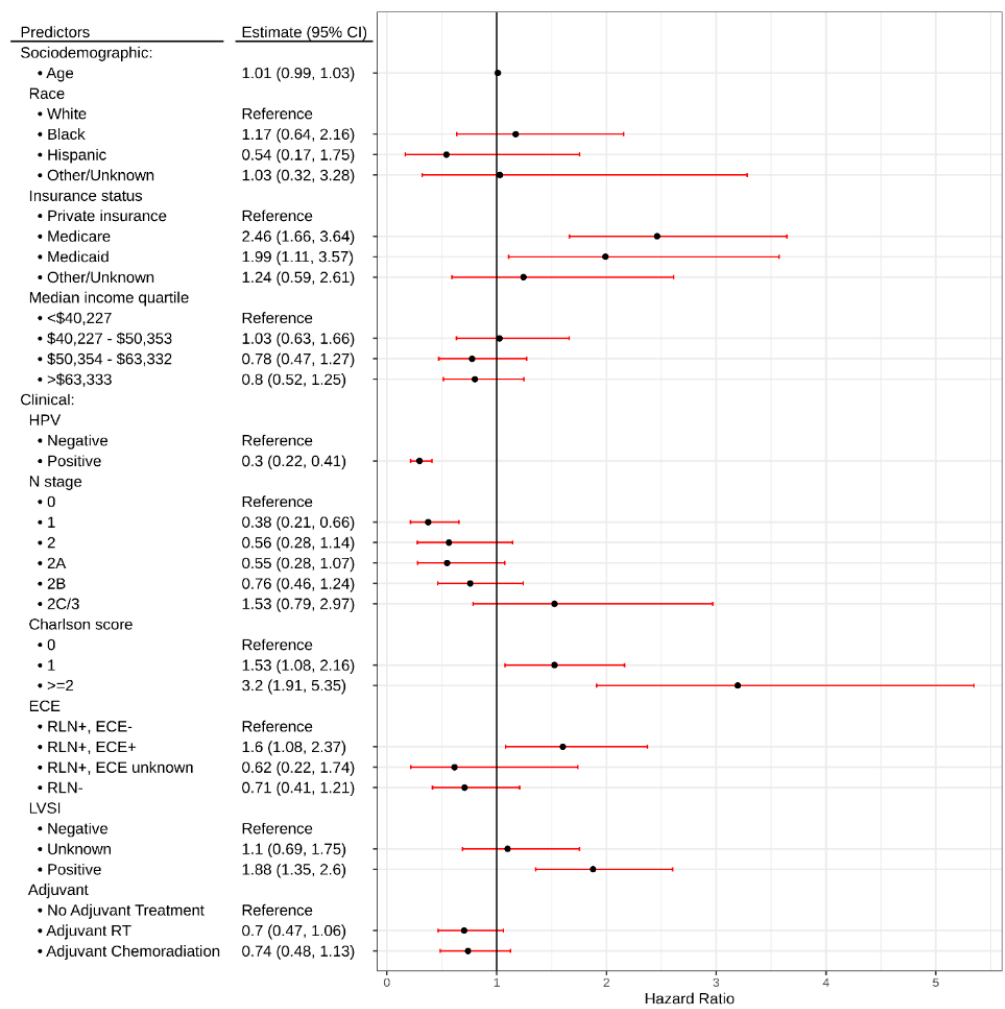
Figure 3. Forrest plot demonstrating hazard ratios for variables associated with survival in Oropharyngeal Squamous Cell Carcinoma patients treated with TORS.